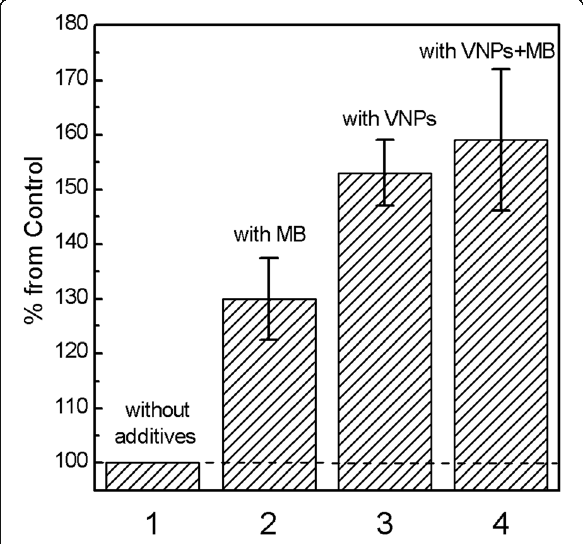
Fig. 2 Relative efficiency of conjugated dienes formation in lipid suspensions: 1 - without additives; 2 - with MB; 3 - with VNPs; 4 - with VNPs-MB